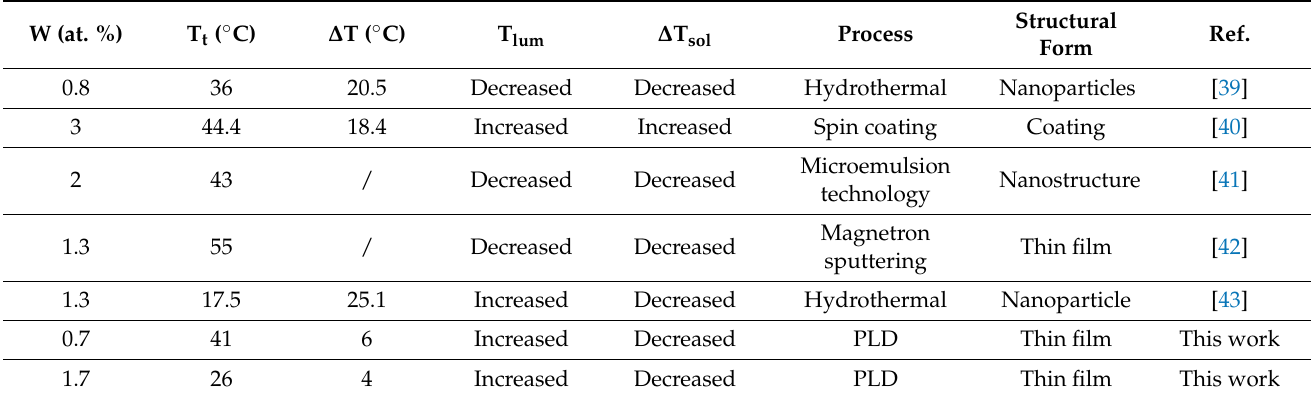
3.2. Surface Chemistry Analysis: Composition and Depth Distribution To analyze the surface chemistry, the high-resolution XPS spectra of V 2p and W 4d core-levels of W-doped VO X (as-deposited) and W-doped VO 2 (after annealing) thin films are shown in Figure 3a,b, respectively.